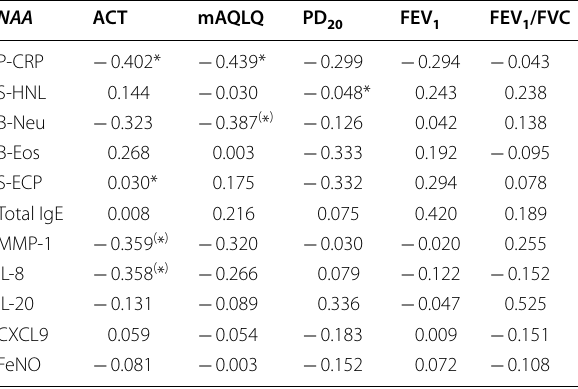
Table 5 Correlations (rho) between clinical outcomes and inflammatory markers in NAA